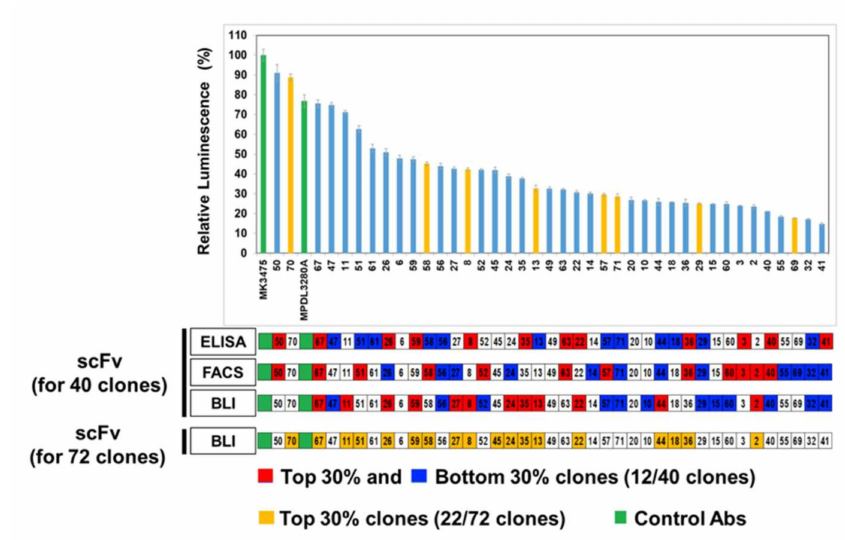
Figure 4. In vitro cell-based PD-1 / PD-L1 inhibition assay in comparison with primary scFv screenings. Evaluation of in vitro assays to assess the inhibition of PD-1-PD-L1 interactions by full IgG antibodies. The activity of 40 full IgG converted antibodies in blocking the e ff ect of the PD1 / PD-L1 checkpoint on TCR-mediated T cell activation is assessed as the level of luciferase activity. MK3475 (anti-PD-1) and MPDL3280A (anti-PD-L1) antibodies were used as positive controls (green bar). The light blue bars have binding activity of antibody clones against human PD-L1 antigen, whereas yellow bars have cross-reactivity to both human and mouse PD-L1 antigens. Results are classified using color shading codes, with the top 30% in red and the bottom 30% in blue in each assay (scFvs 30%; 12 / 40 clones and 22 / 72